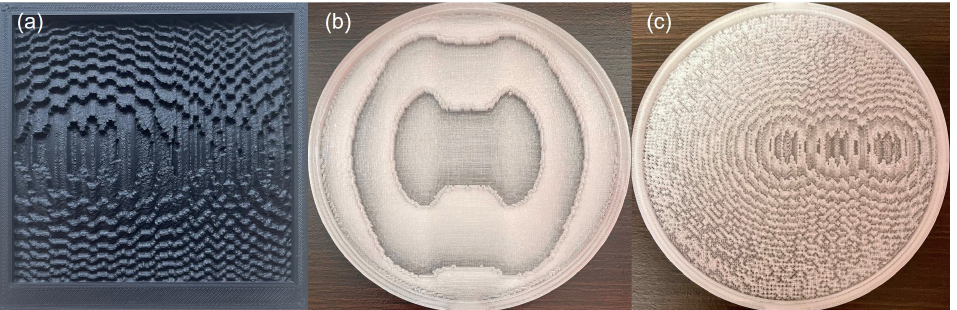
Figure 3. Photographs of the manufactured three-focal-spot lenses: ( a ) f = 100 mm, ν = 140 GHz; ( b ) f = 700 mm, ν = 140 GHz and ( c ) f = 100 mm, ν = 260